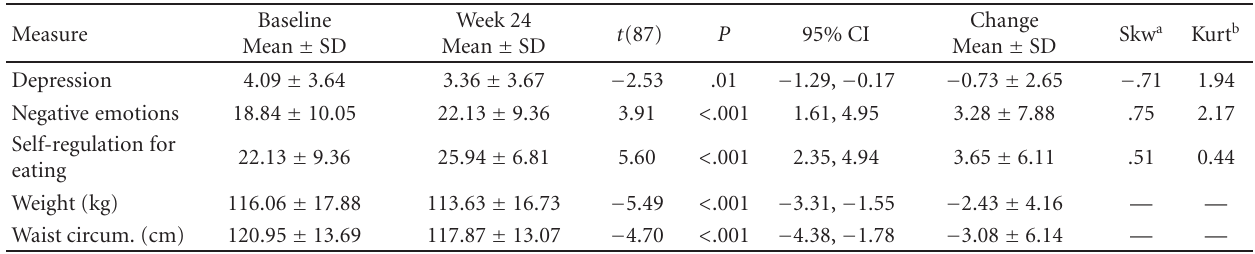
Table 2: Results of multiple regression analyses predicting weight and waist circumference changes, 2011 ( N = 88). β Prediction of weight